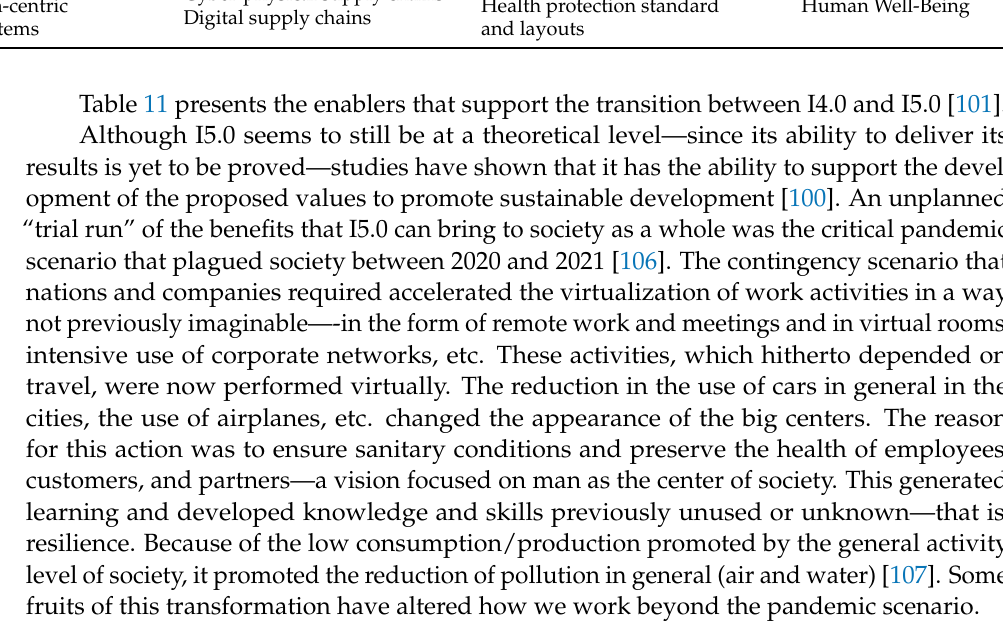
Table 11. Key Enabling Technologies—transition from Industry 4.0 to the concept of Industry